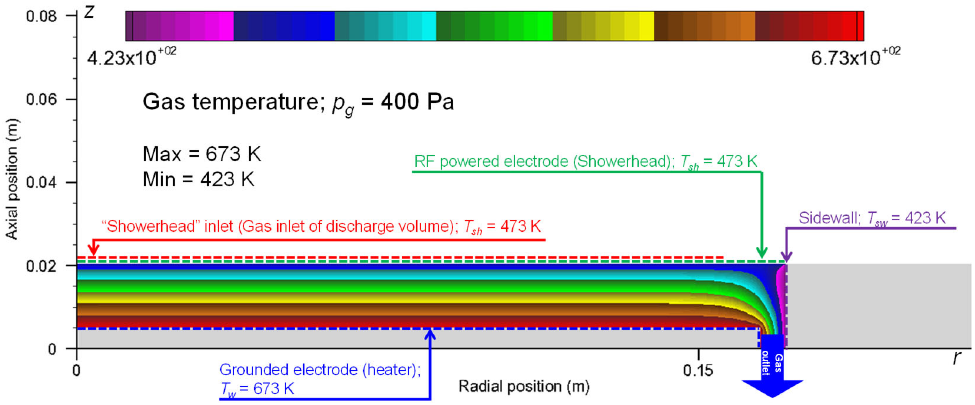
Figure 10. Deposition rate profiles are plotted for Cases 9, 10, 11, and 12. The profiles are normalized with their corresponding averaged values.